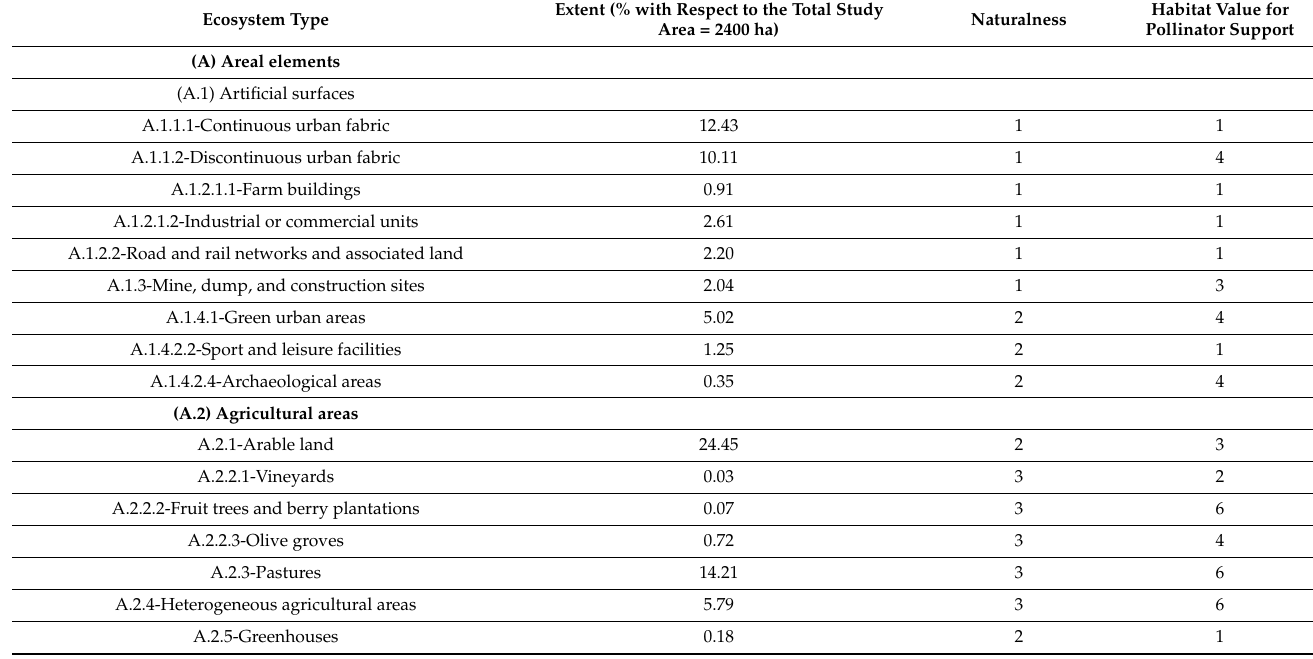
Table 2. Adopted typology for areal (A) and linear (L) actual ecosystems and respective proportional extent, degree of naturalness, and habitat value for pollinator